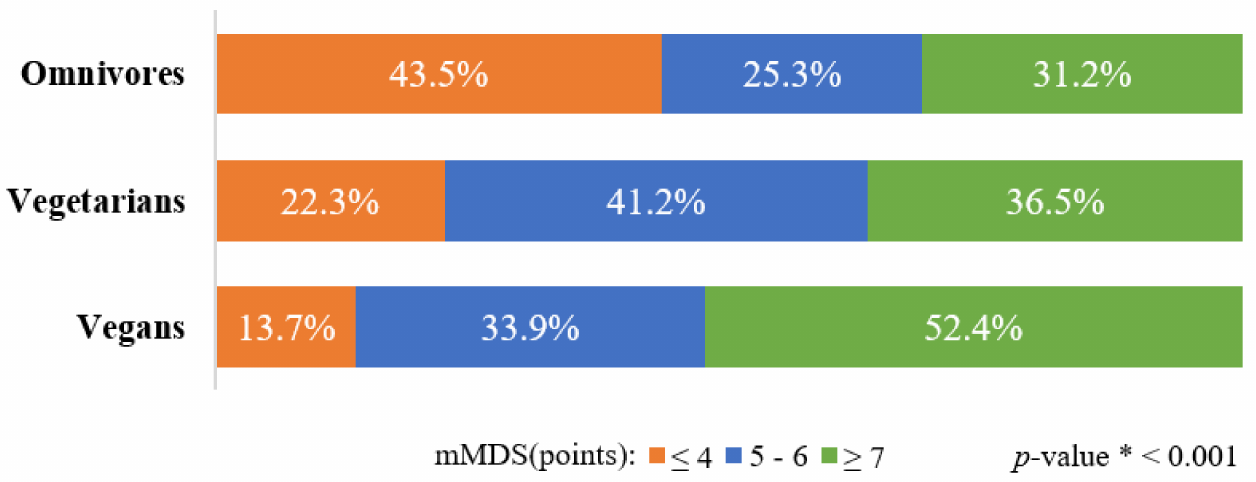
Figure 3. Percentage distribution of omnivores, vegetarians, and vegans by categories of modified Mediterranean diet score (mMDS). * p -value was determined using Chi-square test; mMDS (range 0–10